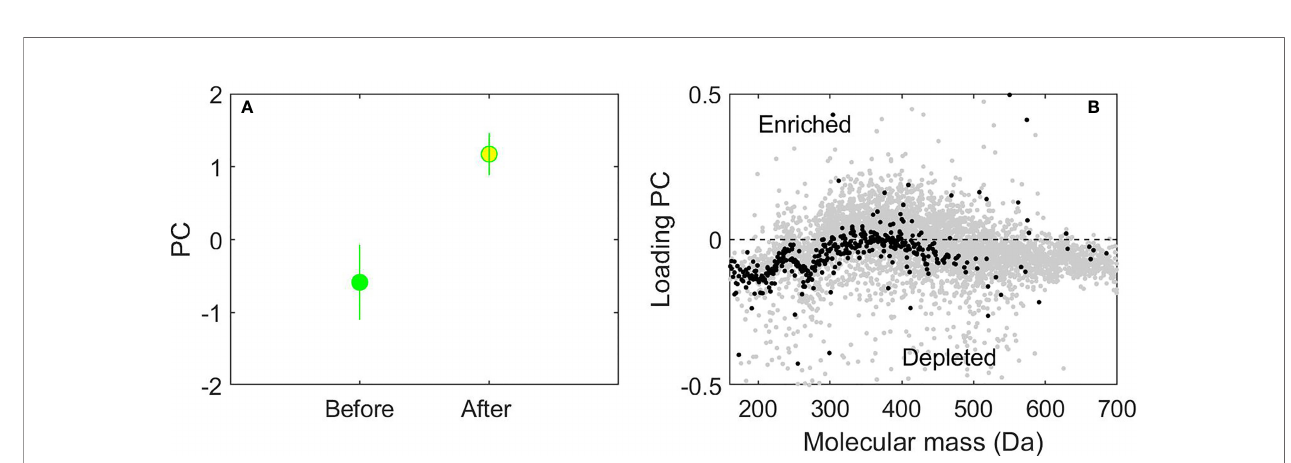
FIGURE 9 | Changes in DOM composition due to biodegradation following a strong freshening event. (A) Score of principal component of DOM composition for samples collected at Sapelo Sound after a high precipitation event in October 2018, before (green) and after (yellow) dark incubation. (B) Loading of PC versus molecular mass (Da). Gray dots indicate all molecular formulae, while the 481 molecular formulae that had their relative abundance strongly increased at Sapelo Sound after extreme events are shown in